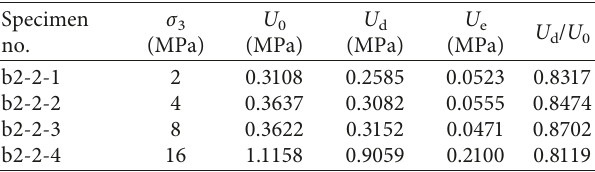
Table 4: The analysis of energy parameters when the stress reaches the